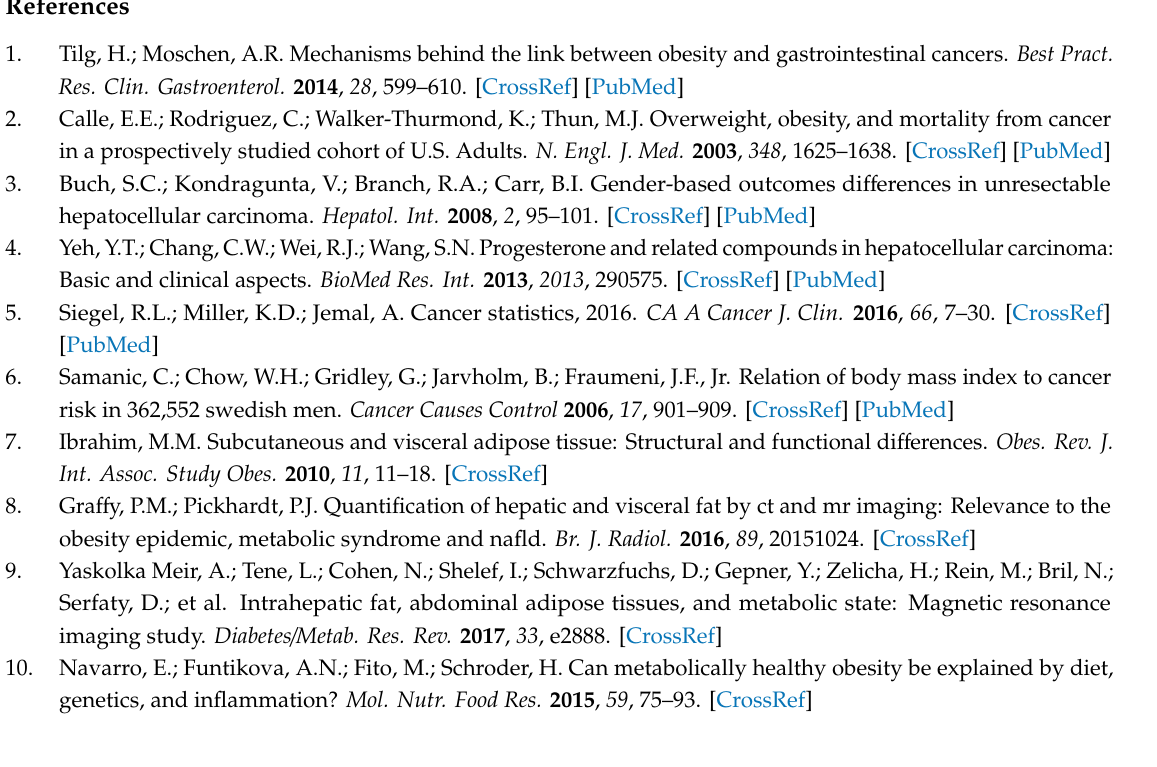
Figure S1: Graphical summary of serum parameters, Figure S2: Zonal expression of periportal E-cadherin and of perivenous glutamine synthase and cytochrome P450 2E1 in livers from wildtype and knockout female and male mice, Figure S3: Expression levels of mRNA coding for proteins involved in lipid metabolism and function in isolated hepatocytes of wildtype and knockout female and male mice after 3 and 5 days of culture, Table S1: List of proteins detected by the Proteome ProfilerTM Mouse Adipokine Array